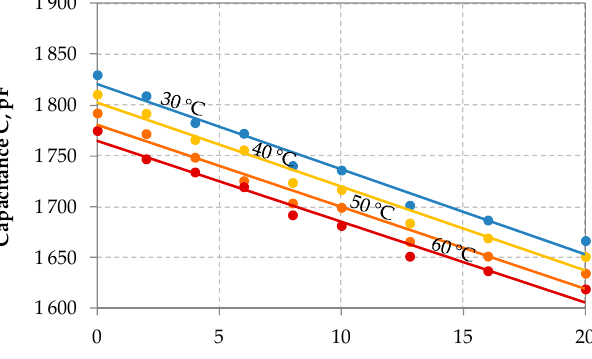
Figure 7. Parameters a and b depending on temperature (trimmer immersed in a mixture of mineral oil and synthetic es- ter).